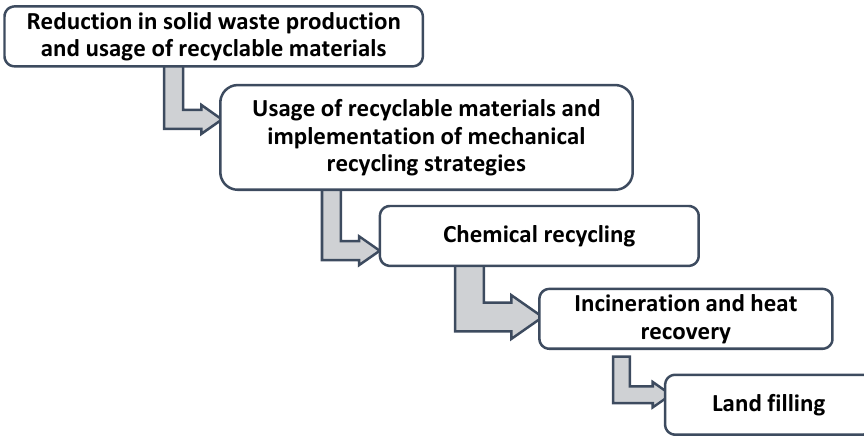
Figure 1. Recommended recycling strategies hierarchy for solid waste management .